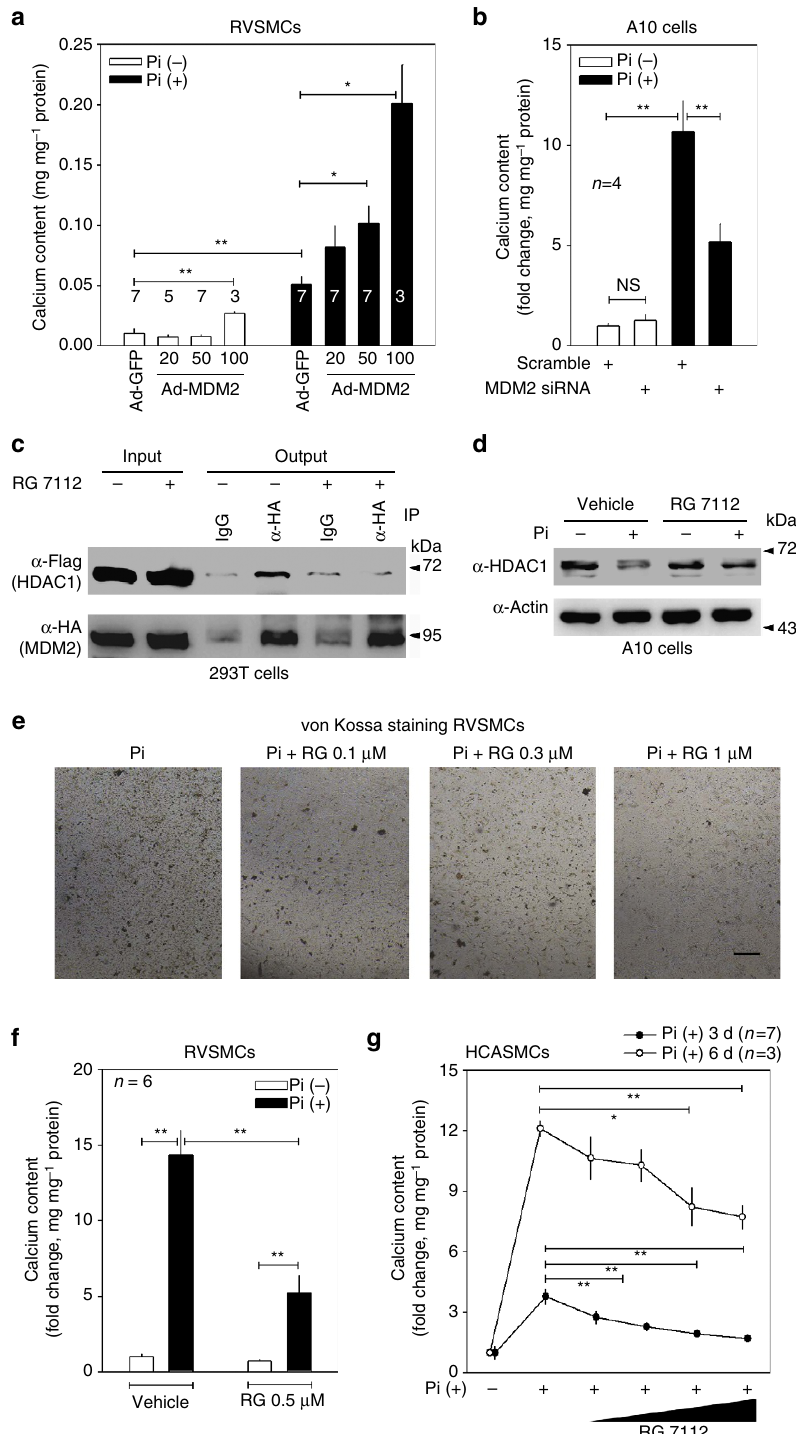
Figure 6 | MDM2 induces VC. ( a ) Adenoviral infection of MDM2 enhanced Pi-induced VC in a dose-dependent manner. Numbers under the horizontal axis are the MOI of adeno-MDM2 ( n ¼ 3–7 from one to two experimental sets). ( b ) MDM2 siRNA blunted Pi-induced VC in A10 cells ( n ¼ 9 from three sets). Either MDM2 siRNA or scramble was transfected with Lipofectamine RNAiMAX. ( c ) Immunoprecipitation analysis to show that RG 7112 (RG), an MDM2 inhibitor, interfered with the association of HDAC1 with MDM2. Note the physical interaction between HDAC1 and MDM2 (fourth lane) was attenuated by RG treatment (sixth lane). HA-MDM2 and Flag-HDAC1 were transfected and either RG (2.5 m M) or vehicle was treated for 24h in 293T cells. ( d ) RG (0.1 m M) blocked the Pi-induced reduction of HDAC1 protein amount in A10 cells. ( e ) RG attenuated Pi-induced VC in RVSMCs in a dose-dependent manner. Pi-containing media with either RG or vehicle were replaced every 2 days for 6 days and von Kossa staining was performed. Scale bar, 100 m m. ( f ) Quantification results to show the inhibitory effect of RG on Pi-induced VC. RG (0.5 m M) significantly reduced the calcium deposition in RVSMCs ( n ¼ 6 from two sets). ( g ) Dose-dependent attenuation of calcium deposition by RG compound (0.1–3 m M) in human coronary artery smooth muscle cells (HCASMCs). Pi was treated for 3 days (filled circle, n ¼ 7 from two sets) or 6 days (open circle, n ¼ 3 from one set). * P o 0.05, ** P o 0.01. NATURE COMMUNICATIONS|7:10492|DOI: